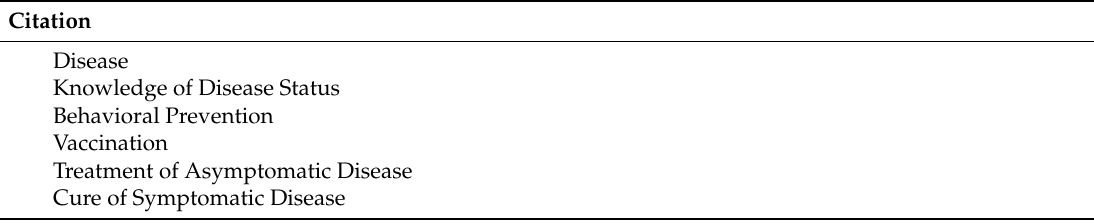
Table A1. Value of Outcomes.